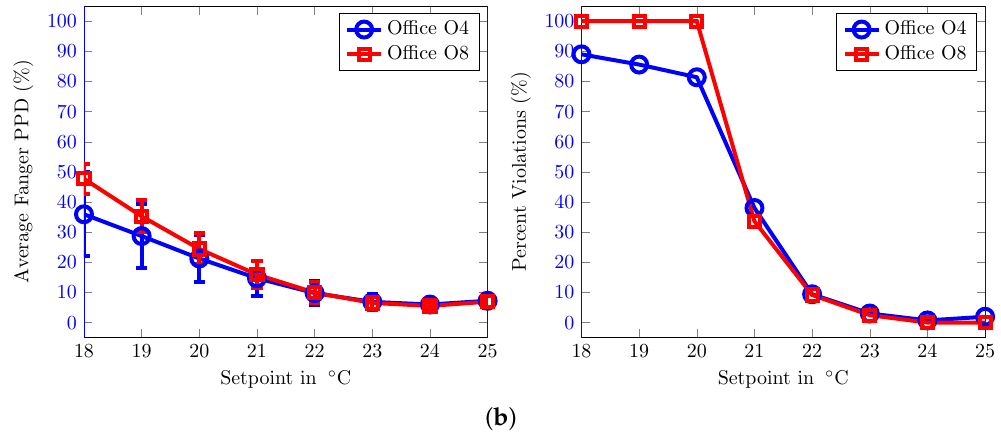
Figure 15. Winter experiments with different set-points. ( a ) User comfort evaluation for different air temperature set-points for the winter period; and ( b ) user comfort evaluation for different operative temperature set-points for the winter